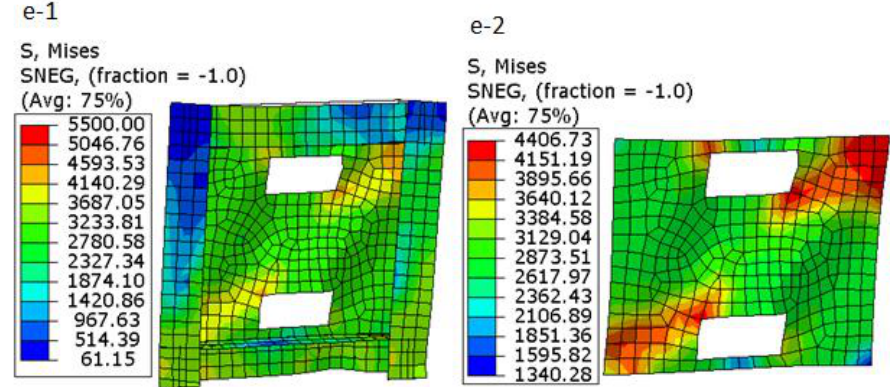
Figure 16. Von Mises stress for shell part ( e-1 ) frame part and ( e-2 ) steel plate.